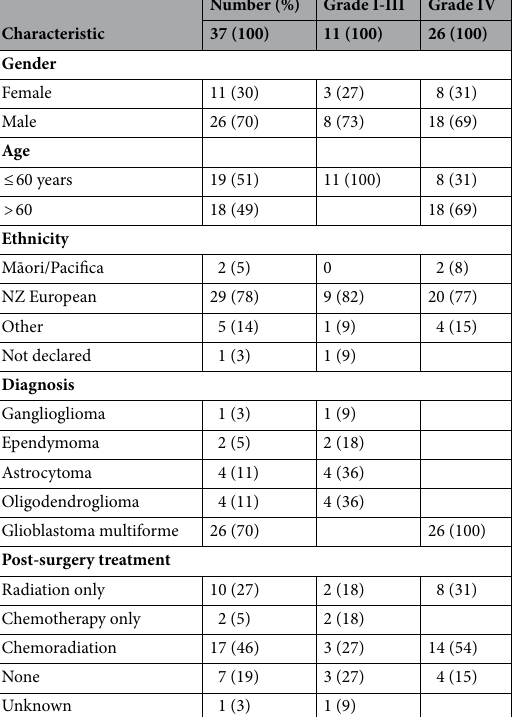
Table 1. Patient